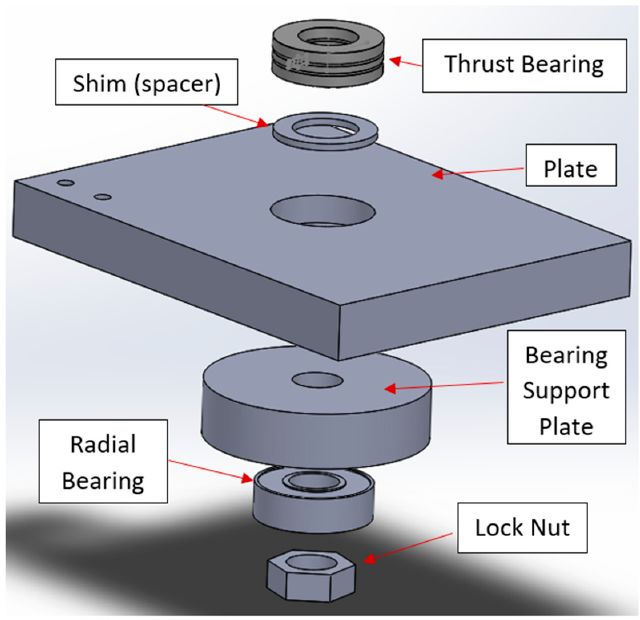
Figure 4. Support system design.